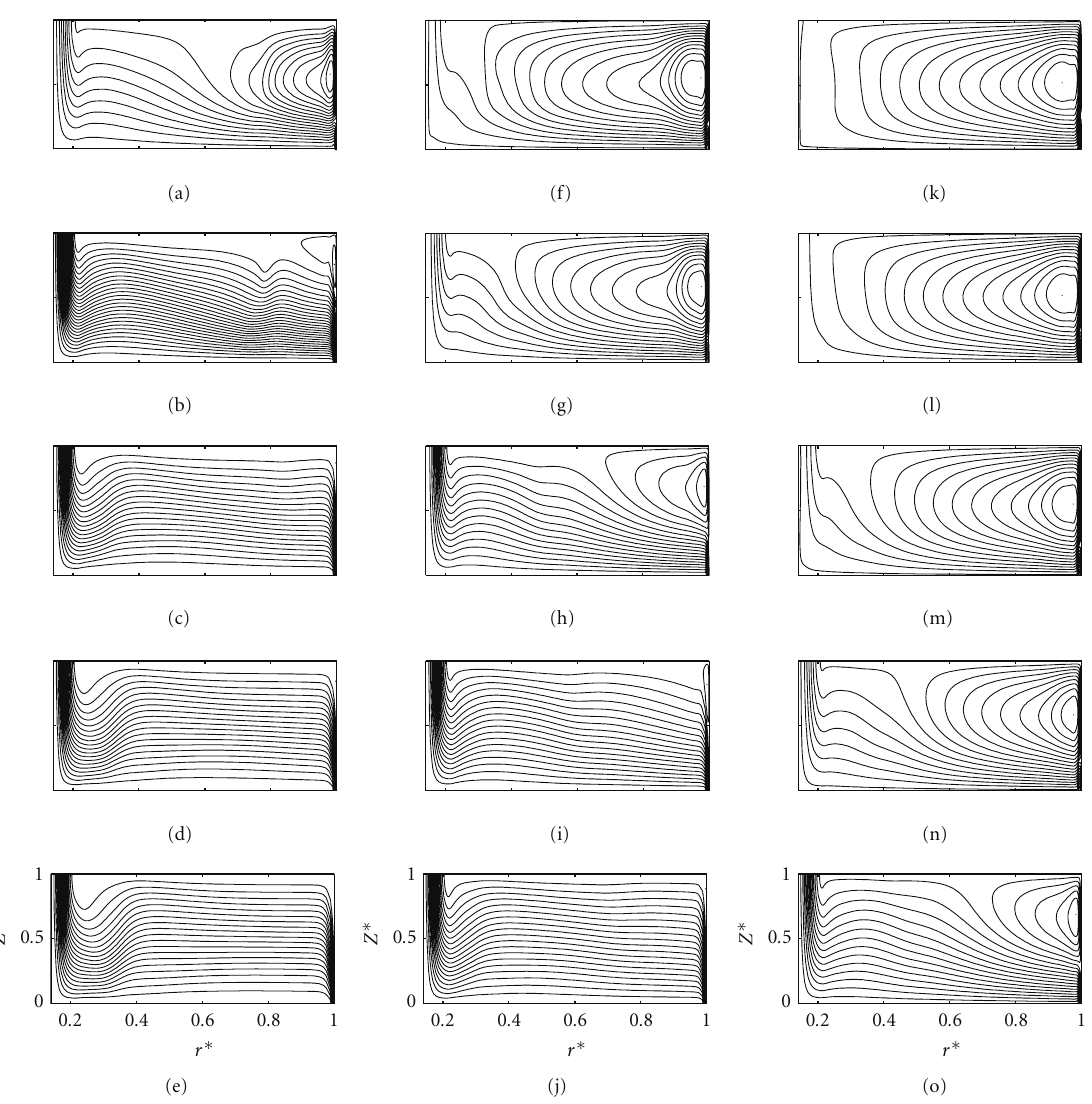
Figure 17: 20 streamline patterns Ψ ∗ for G = 0 . 02 and various sets of parameters (Re, C w ): (a) (1 . 8 × 10 5 , − 500), − 3 . 67 ≤ Ψ ∗ ≤ 125 .